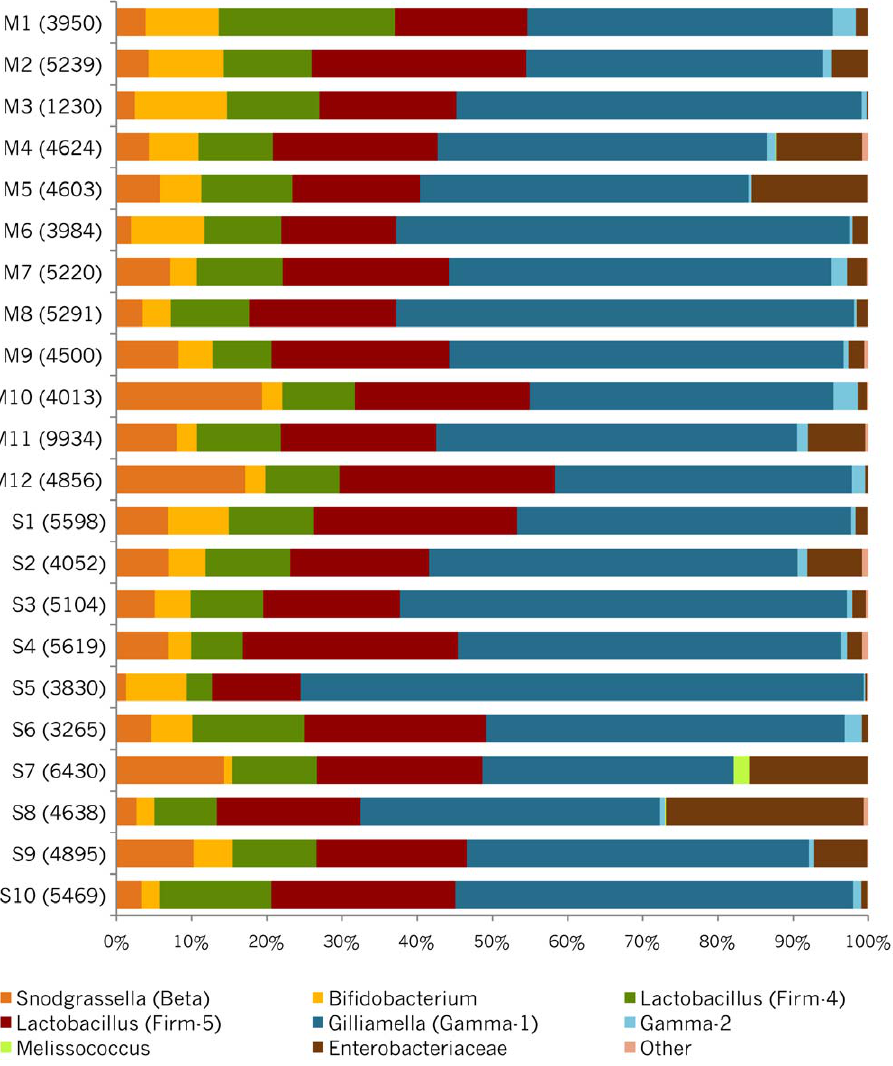
Figure 1. Relative abundances of the typical bee-associated bacterial species in the Mattila et al. (2012) dataset. ‘‘Other’’ includes the CFB-1 species group, which was uncommon in all samples.